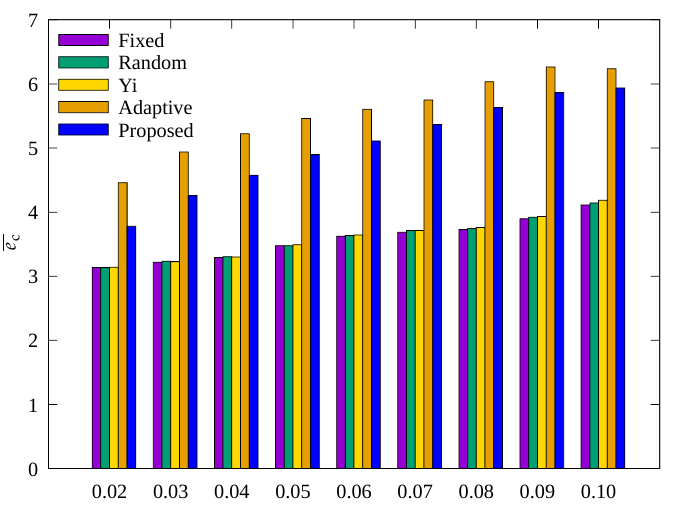
Figure 15. Comparison of the average amount of consumed energy according to density.